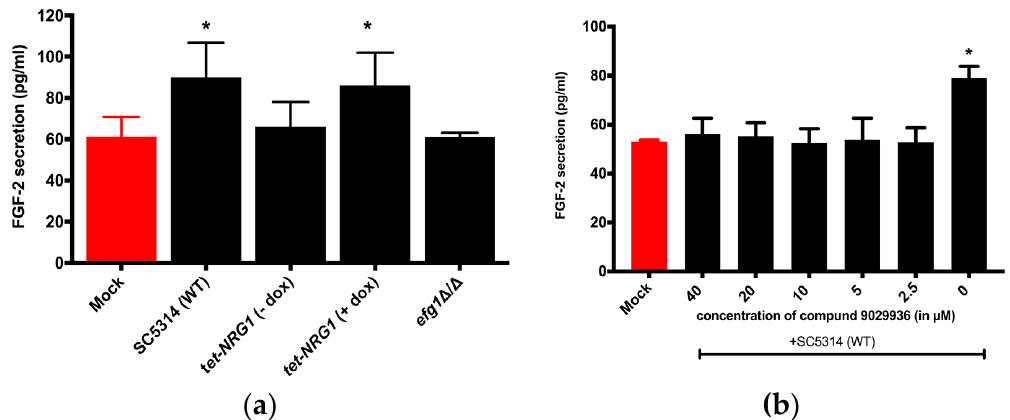
Figure 1. Host Fibroblast Growth Factor-2 (FGF-2) response is dependent on the morphology of C. albicans. ( a ) Human Umbilical Vein Endothelial Cells (HUVECs) were challenged with SC5314 (wild-type, WT), tet-NRG1 (+/- dox), or efg1 △ / △ strains for 24 hours. FGF-2 levels were measured using ELISA. One-way ANOVA was significant ( p = 0.0005). Dunnett’s multiple comparison was used to compare each infected group with the uninfected group (mock). A p value of <0.05 was considered to be significant, as indicated by (*). ( b ) HUVECs were challenged with the wild-type strain SC5314 in the presence (40 to 2.5 µM) or absence (0 µM) of compound 9029936 for 24 hours, and the amount of FGF-2 measured in the supernatants. One-way ANOVA was significant ( p = 0.042). Dunnett’s multiple comparison test demonstrated a statistically significant difference (* p < 0.05) only between the Mock group and the infected group without compound 9029936 treatment (0 µM).